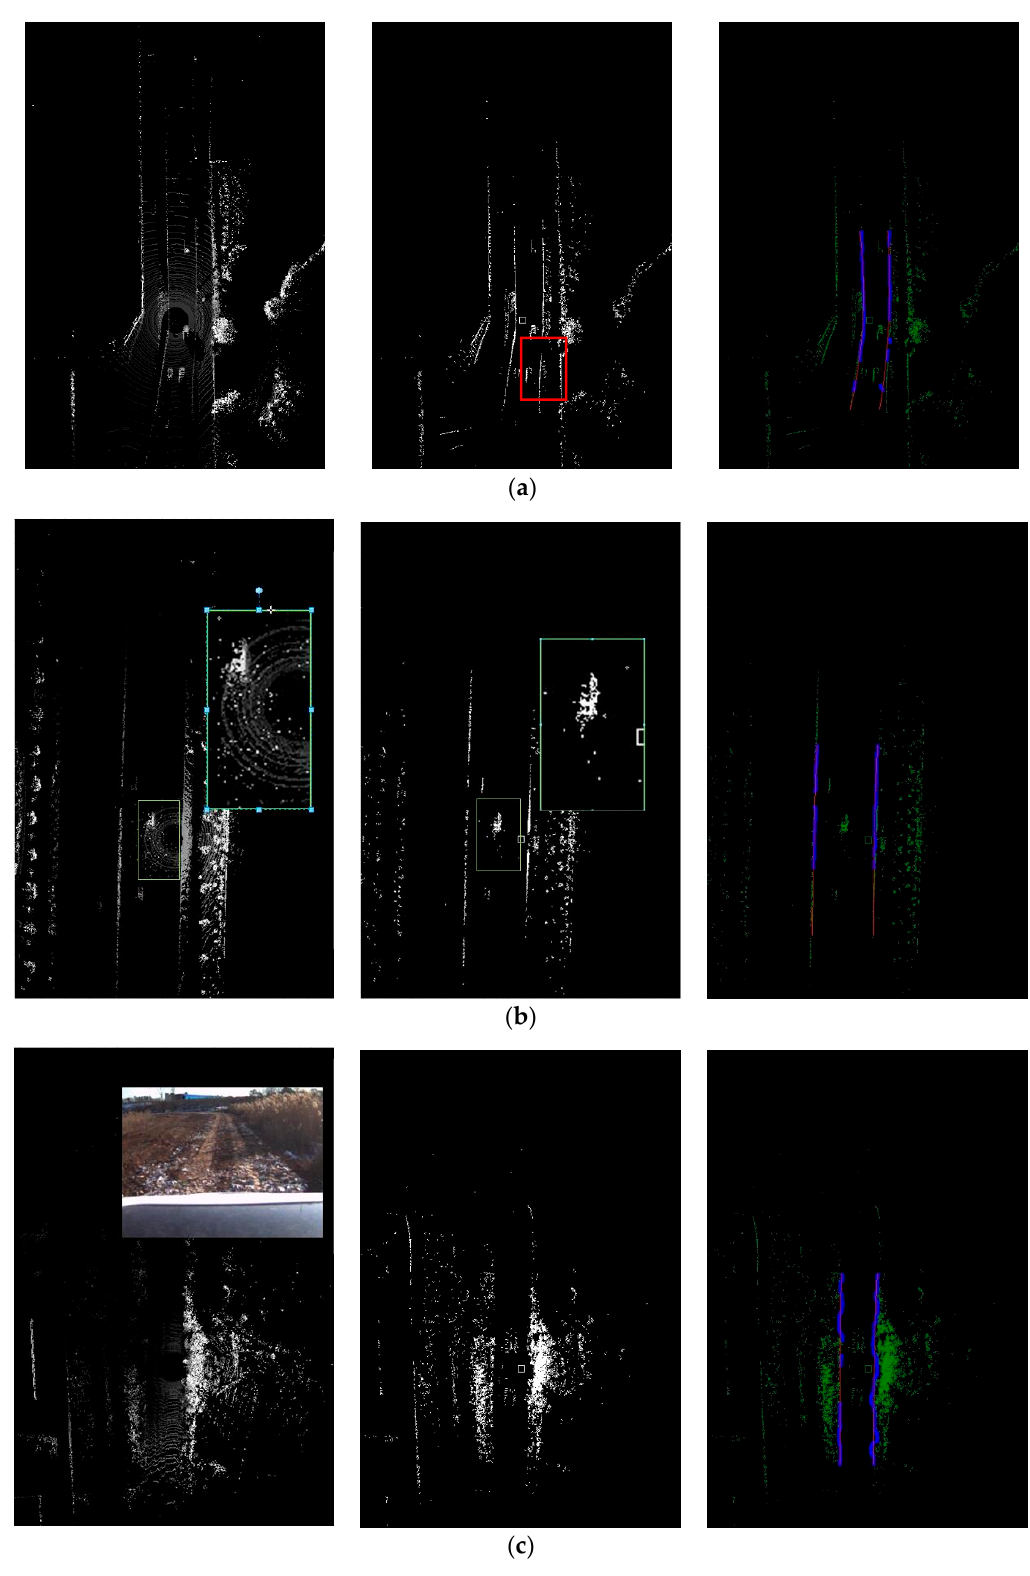
Figure 21. Road curb detection result under different scenes. ( a ) An urban scene; ( b ) A snowy scene; ( c ) A field scene.